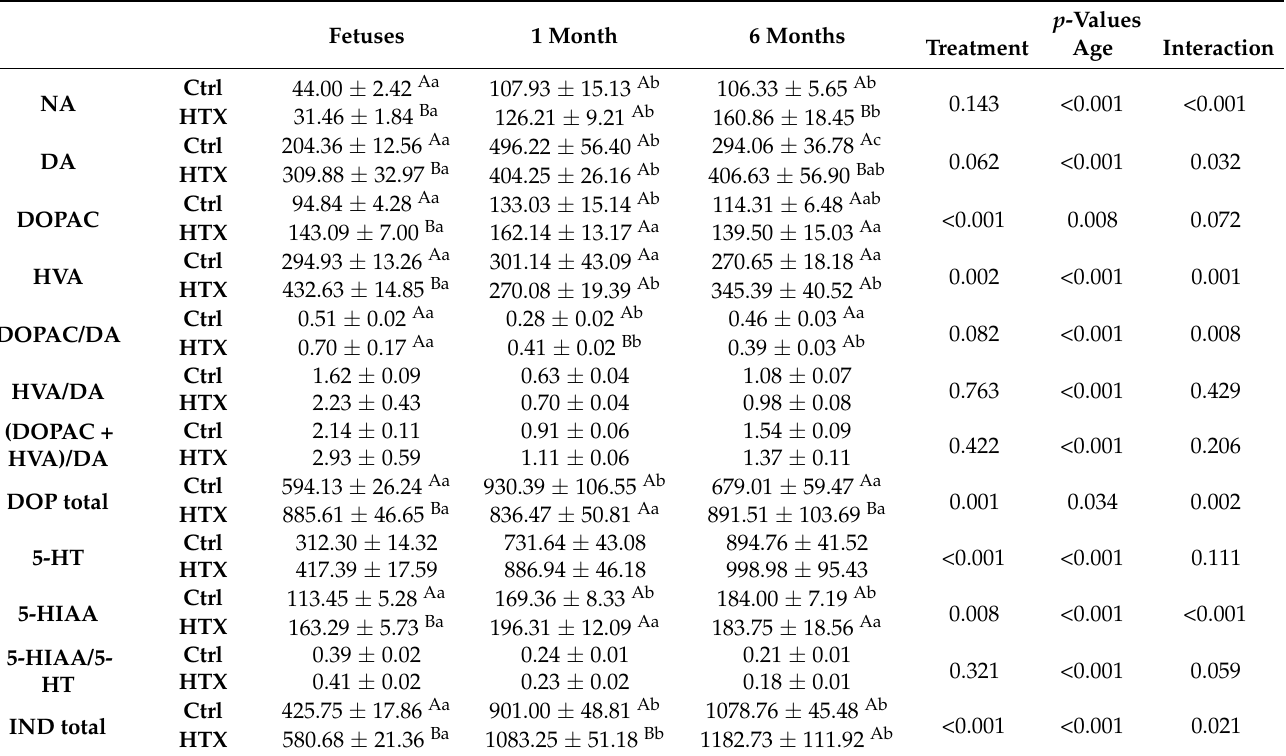
Table 1. Effects of the supplementation of the maternal diet without (Ctrl) or with HTX on the mean values of the concentration of neurotransmitters in the amygdala of 100-day fetuses and 1-month- and 6-month-old